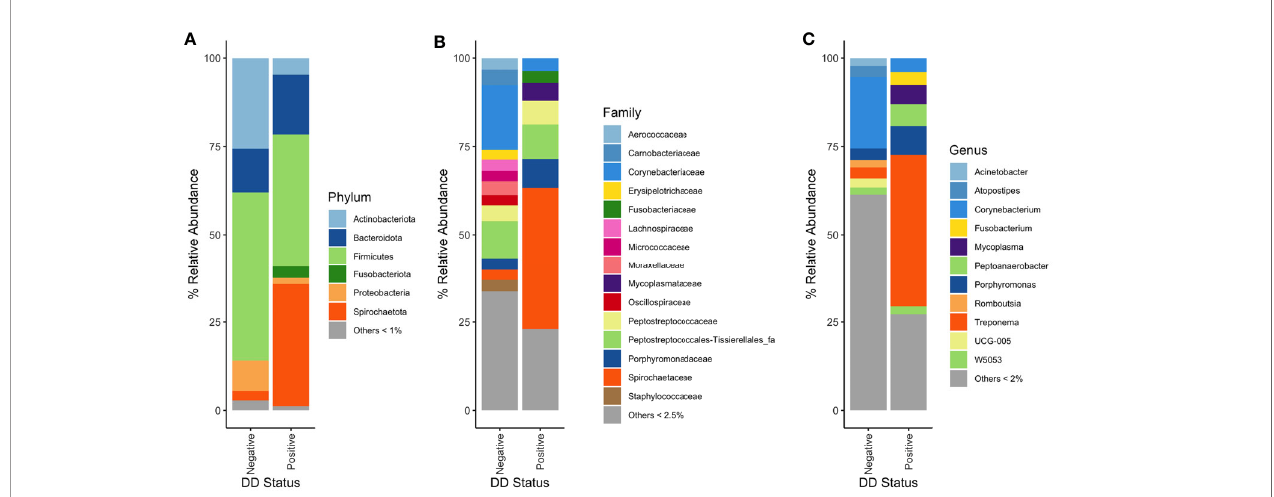
FIGURE 2 | Mean percent relative abundances of microbiota in DD negative and DD positive skin. (A) Taxa were grouped at the phylum level, and all taxa that had less than 1% relative abundance were grouped. Taxa were grouped at the (B) family and (C) genus level, and all taxa that had less than 2.5% and 2% relative abundance, respectively, were grouped.